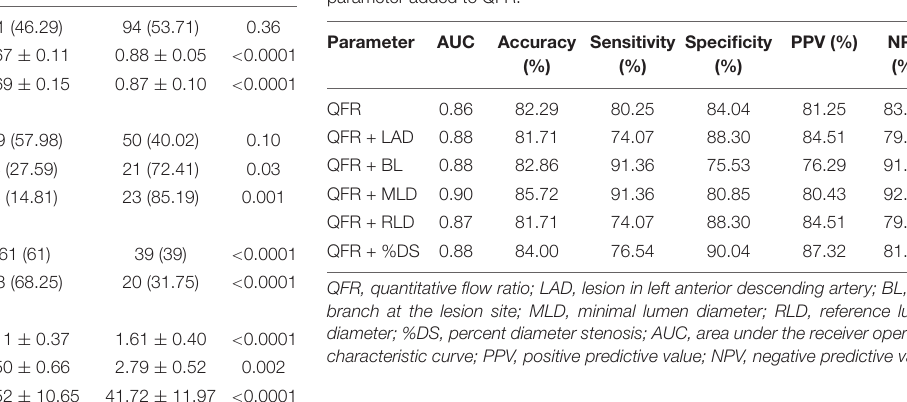
TABLE 4 | Performance of combined models with single lesion parameter added to